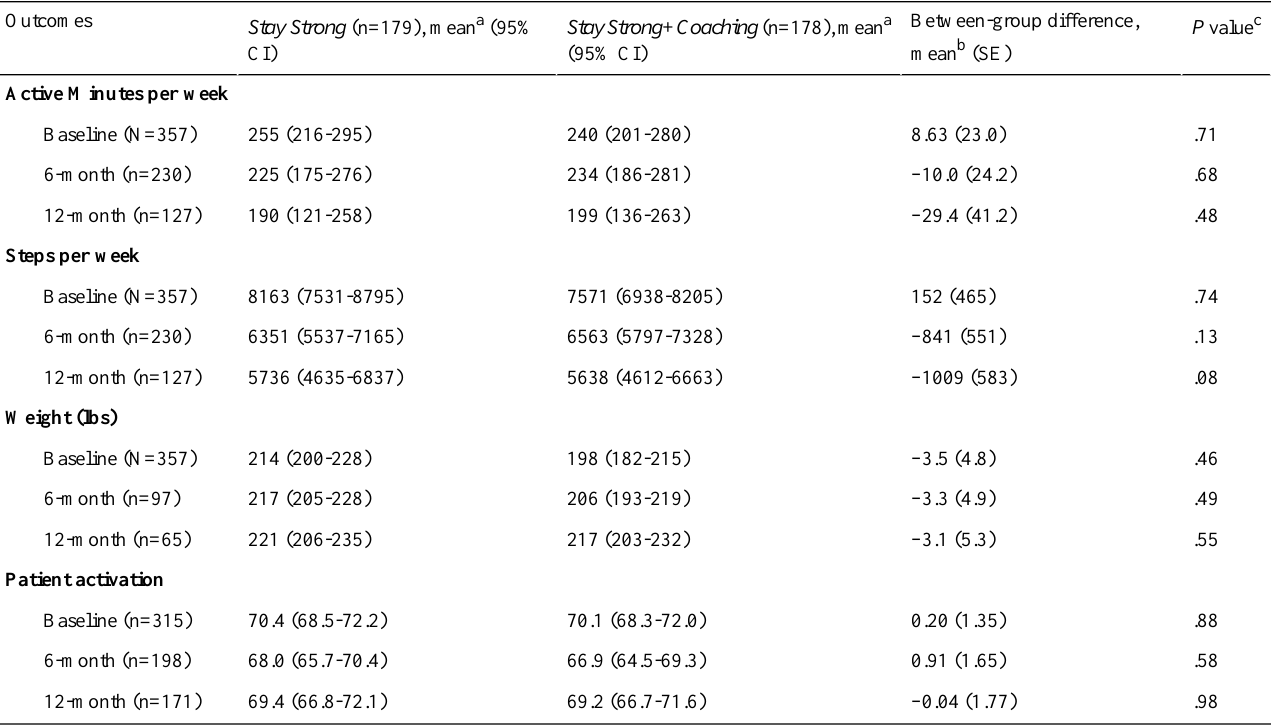
Table 3. Primary outcome of Active Minutes and secondary outcomes of steps, weight, and patient activation for each major assessment time.